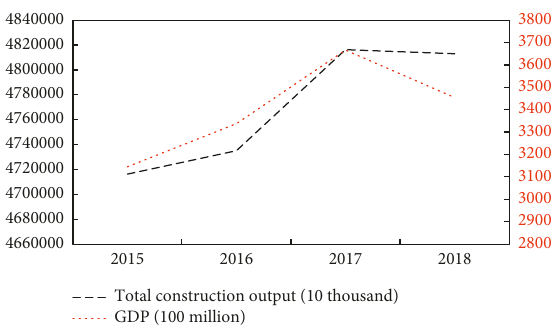
Figure 2: Total construction output and gross domestic product (GDP) from 2015 to 2018 in Handan.